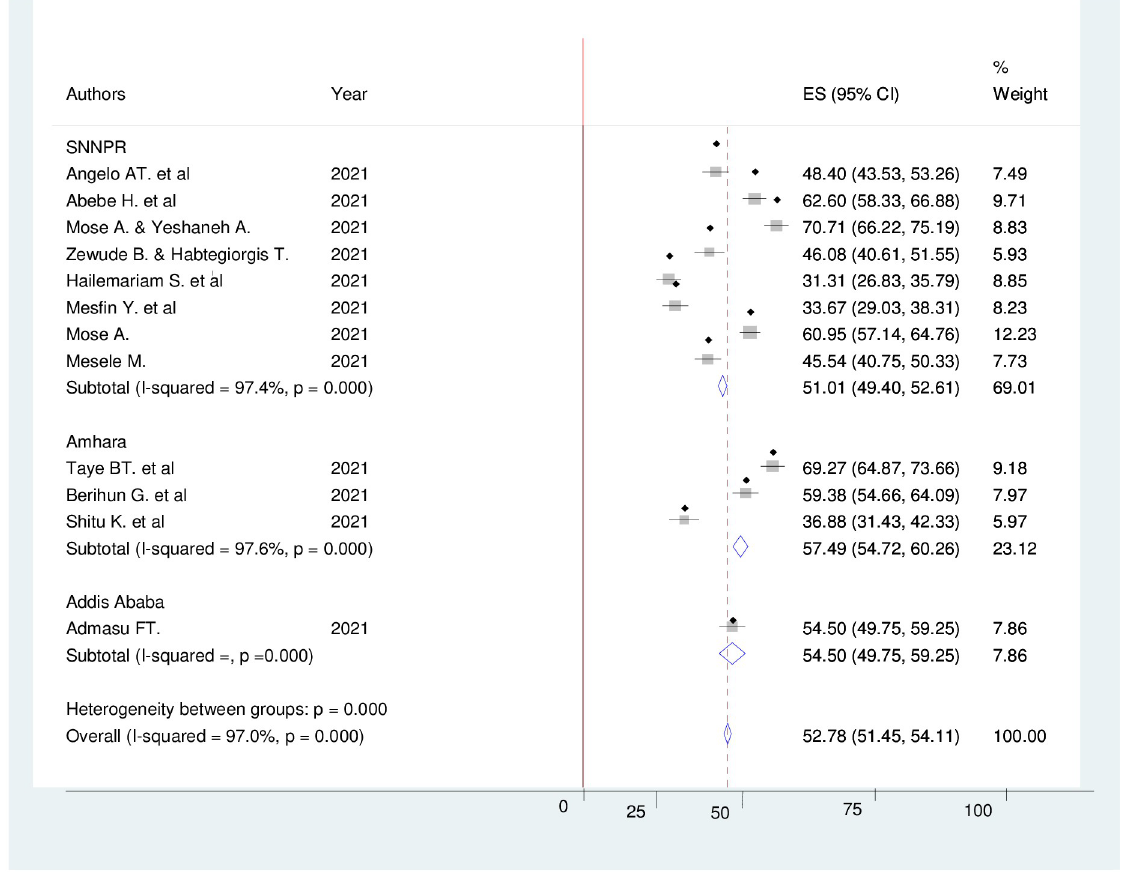
Fig 4. Forest plot showing sub group analysis of COVID-19 vaccine acceptance and its determinant factors by region in Ethiopia, 2021.